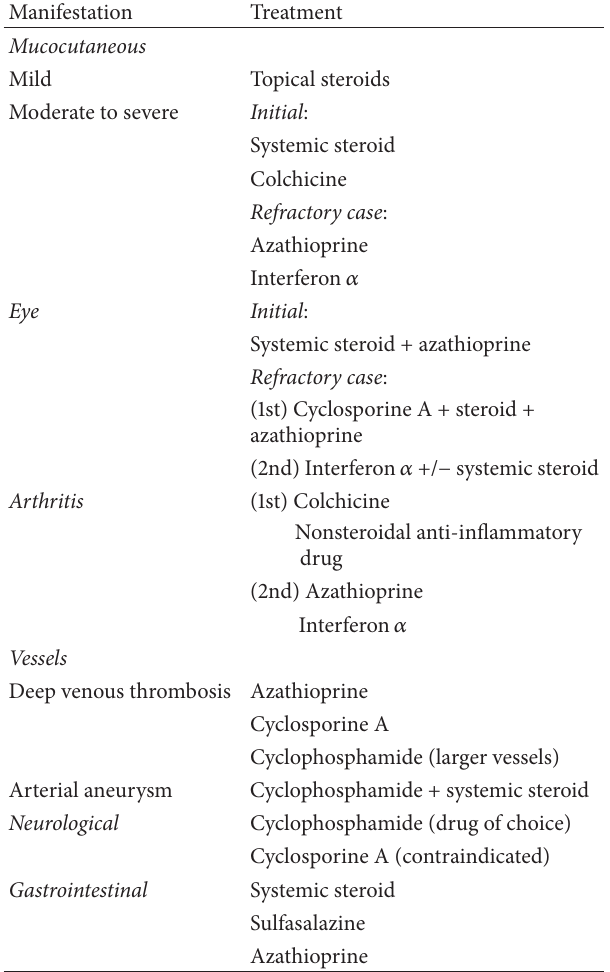
Table 5: Summary of recommended treatment [41,